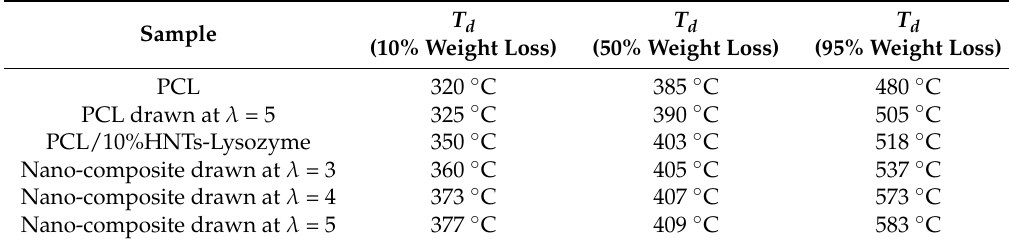
Table 1. Thermal data for all nanocomposites and unfilled PCL, evaluated from TGA.